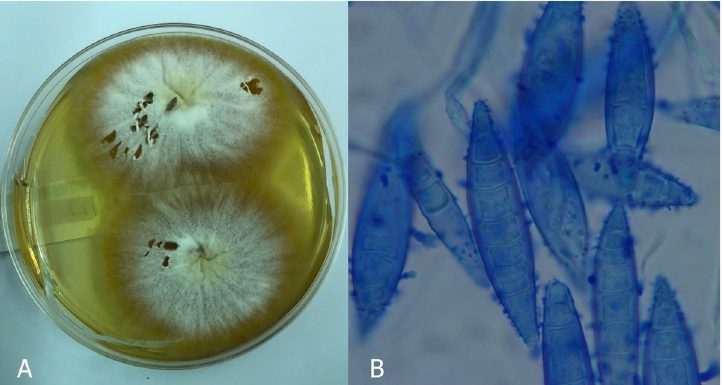
Fig 1. Microsporum canis dermatophyte. (A) Macroscopic identification of M . canis dermatophyte. Grown at 23˚C on SDA with a filamentous form, raised center and flat periphery. Has white to cream color. (B) Microscopic identification of M . canis dermatophyte. Numerous spindle-shaped macroconidia with 5–10 cells.